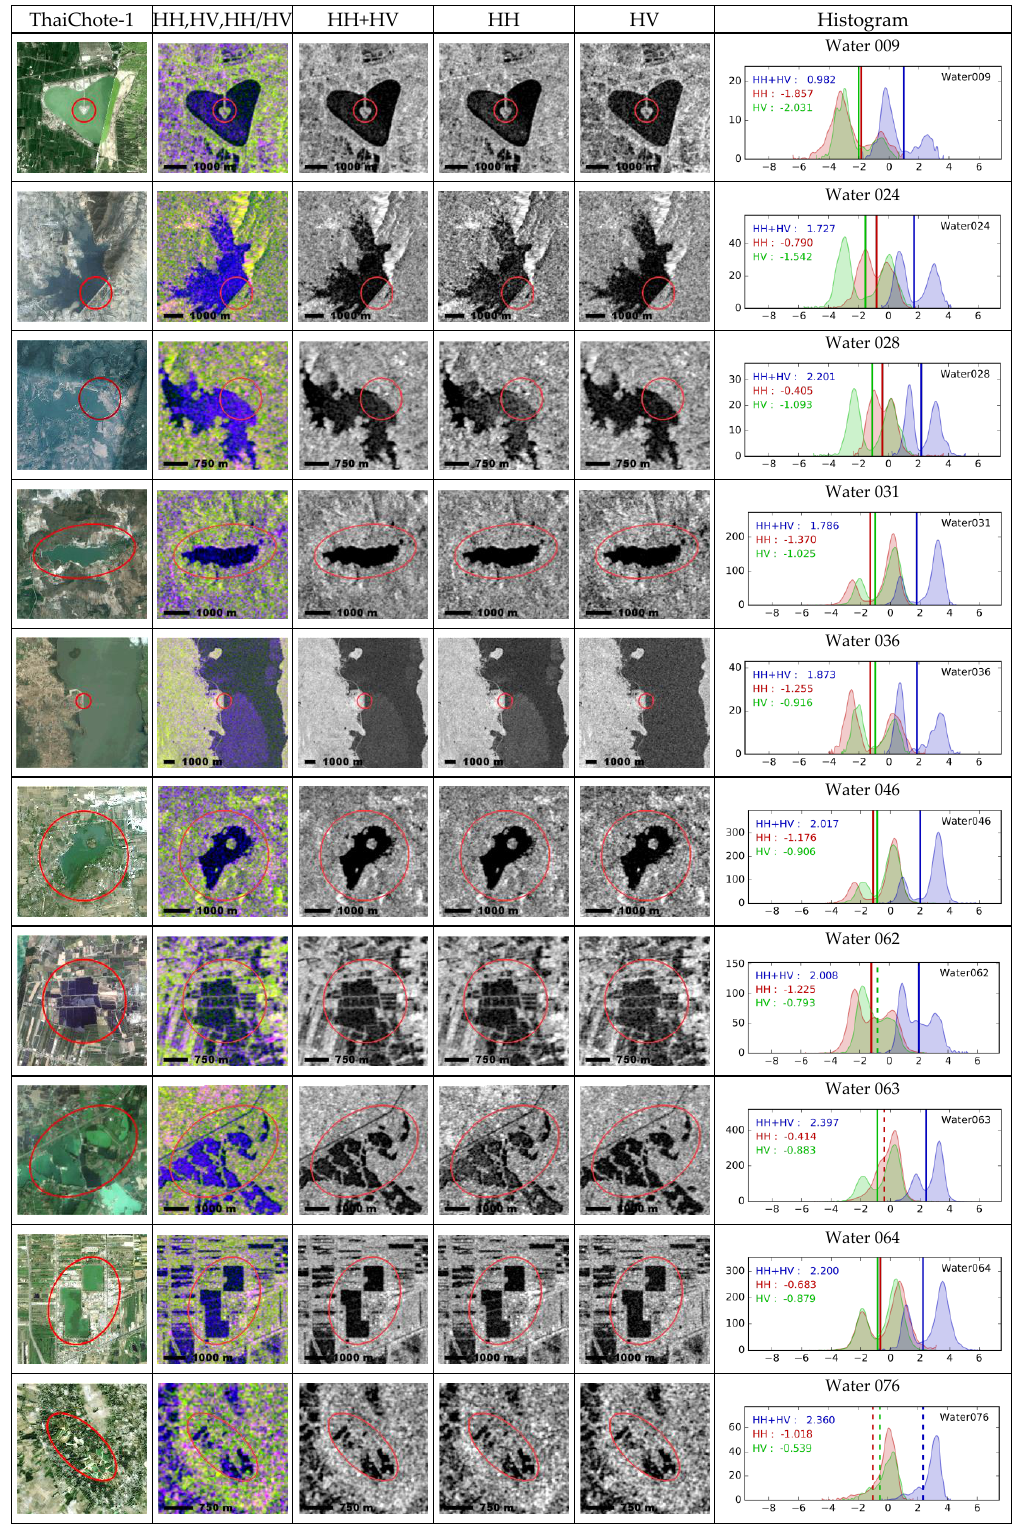
Figure 4. Automated threshold values using the neighborhood valley method of water references in the red elliptical areas (10 of 87) from the HH, HV and HH + HV sigma-naught values taken on the evening of 28 November 2011 PM (1 of 30 in Table 2). The dashed lines represent unimodal distributions, and the solid lines represent bimodal distributions. The ThaiChote-1 images in the first column were acquired on different dates in the dry season.